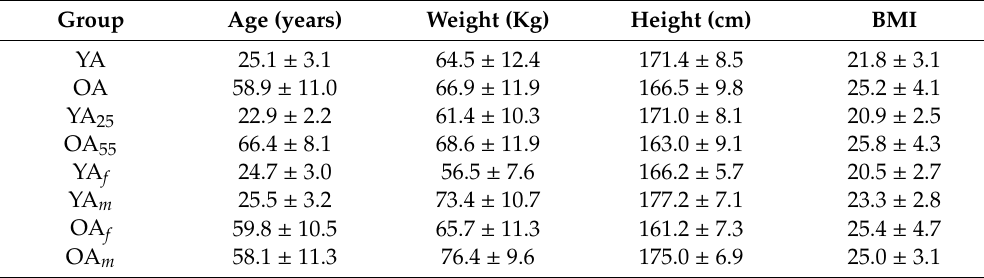
Table 1. Demographic and clinical characteristics of the